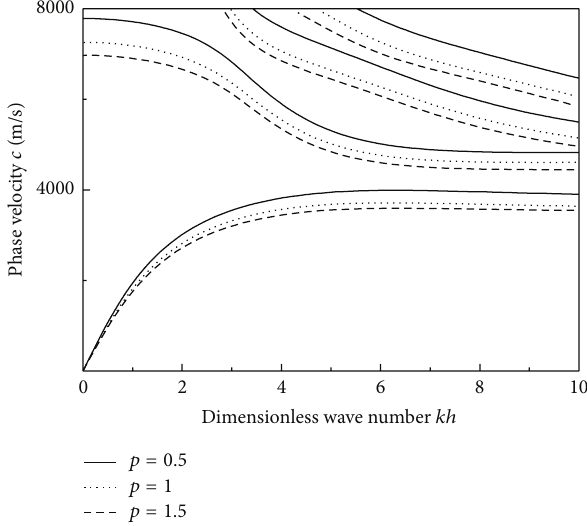
Figure 3: Dispersion curves of first four modes of Lamb waves in FGM